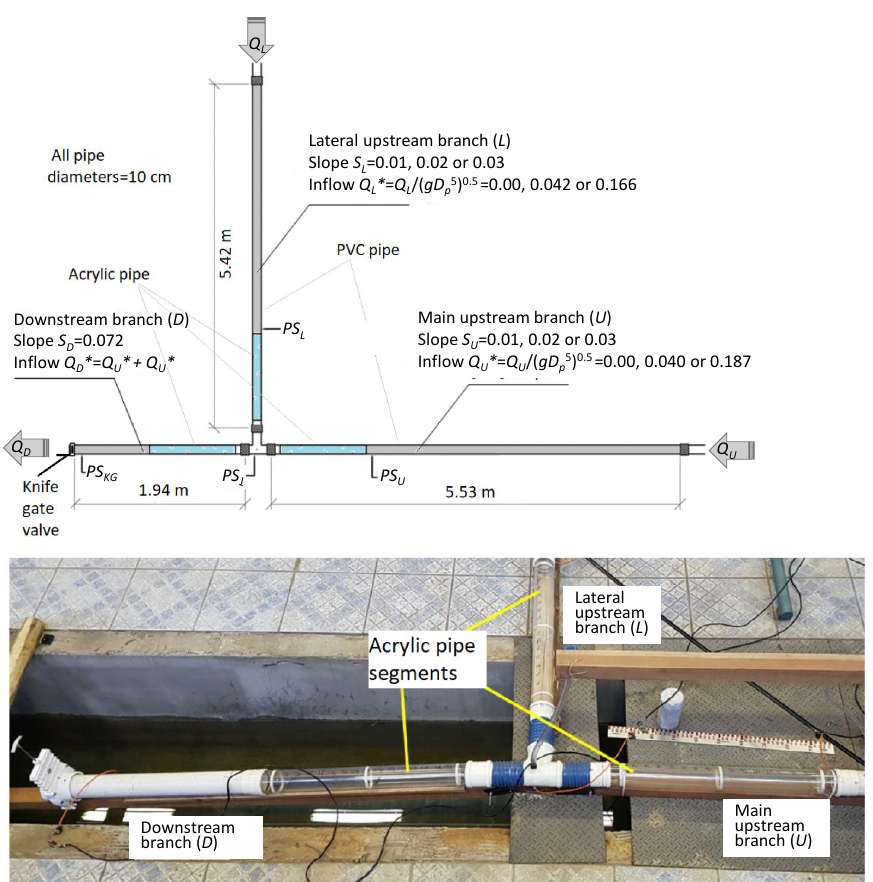
Figure 1. Sketch of experimental setup and picture of the apparatus near the